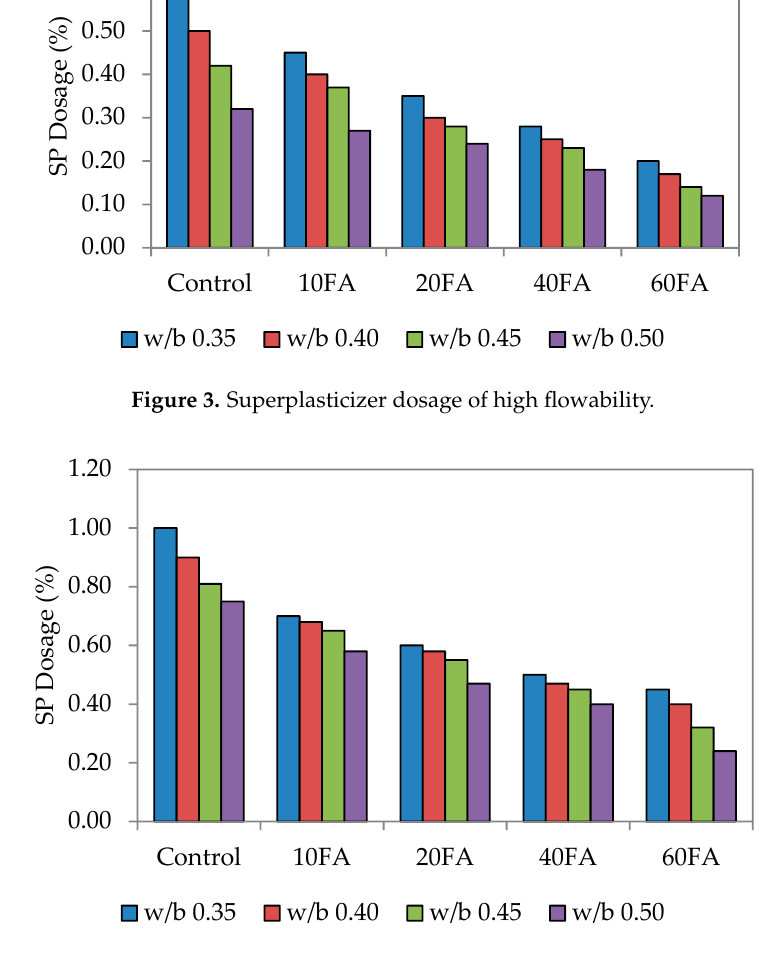
Figure 4. Superplasticizer dosage of self-compacting flowability.